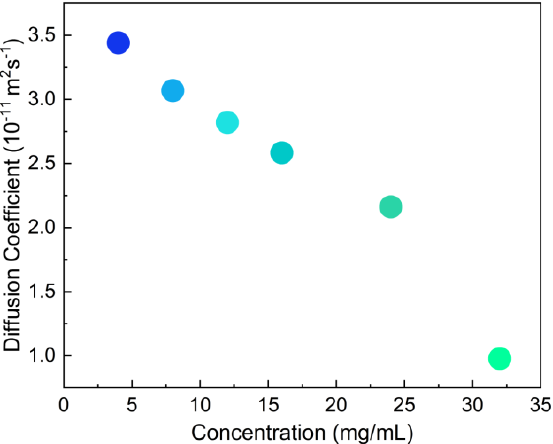
Figure 2. Diffusion coefficients of PPMU at 298 K in CDCl 3 at different concentrations.